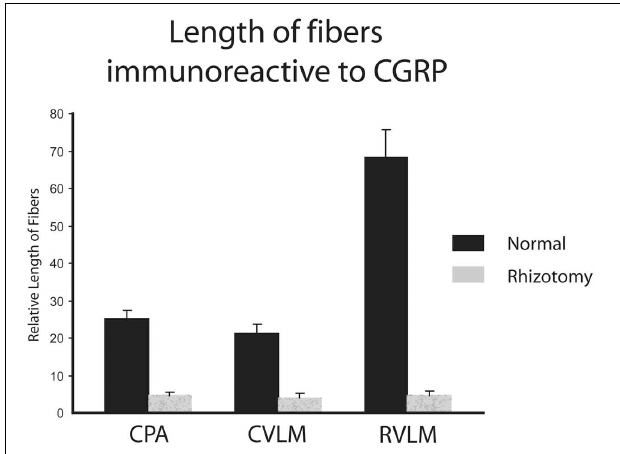
FIGURE 4 | Bar graphs illustrating the loss of immunostained CGRP fibers in the medullary reticular formation after unilateral trigeminal rhizotomy. The length of fibers was summed over several sections. Note the marked reduction of fibers in the caudal pressor area (CPA), caudal (CVLM), and rostral (RVLM) ventrolateral medulla after sectioning the trigeminal root, suggesting a primary afferent source from the trigeminal nerve of these